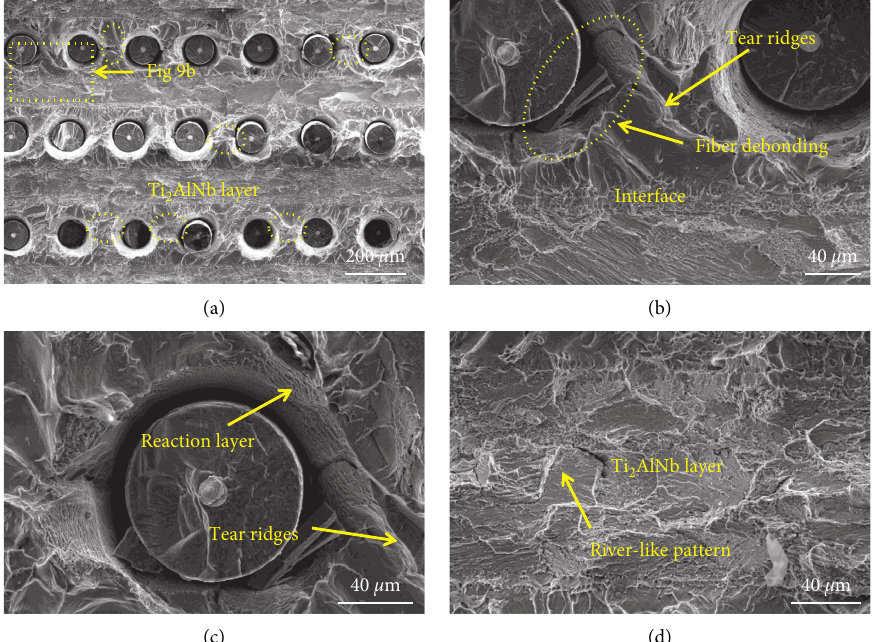
Figure 9: Three-point bending fracture of the composite: (a) macrofracture; (b) fracture of one laminated component; (c) fracture in the SiC f /Ti interface, and (d) fracture in the Ti 2 AlNb